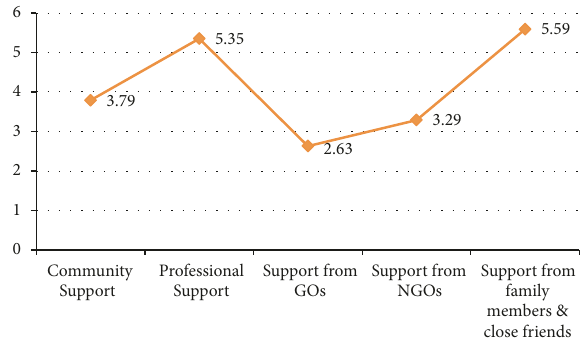
Figure 3: Level of support from each source of